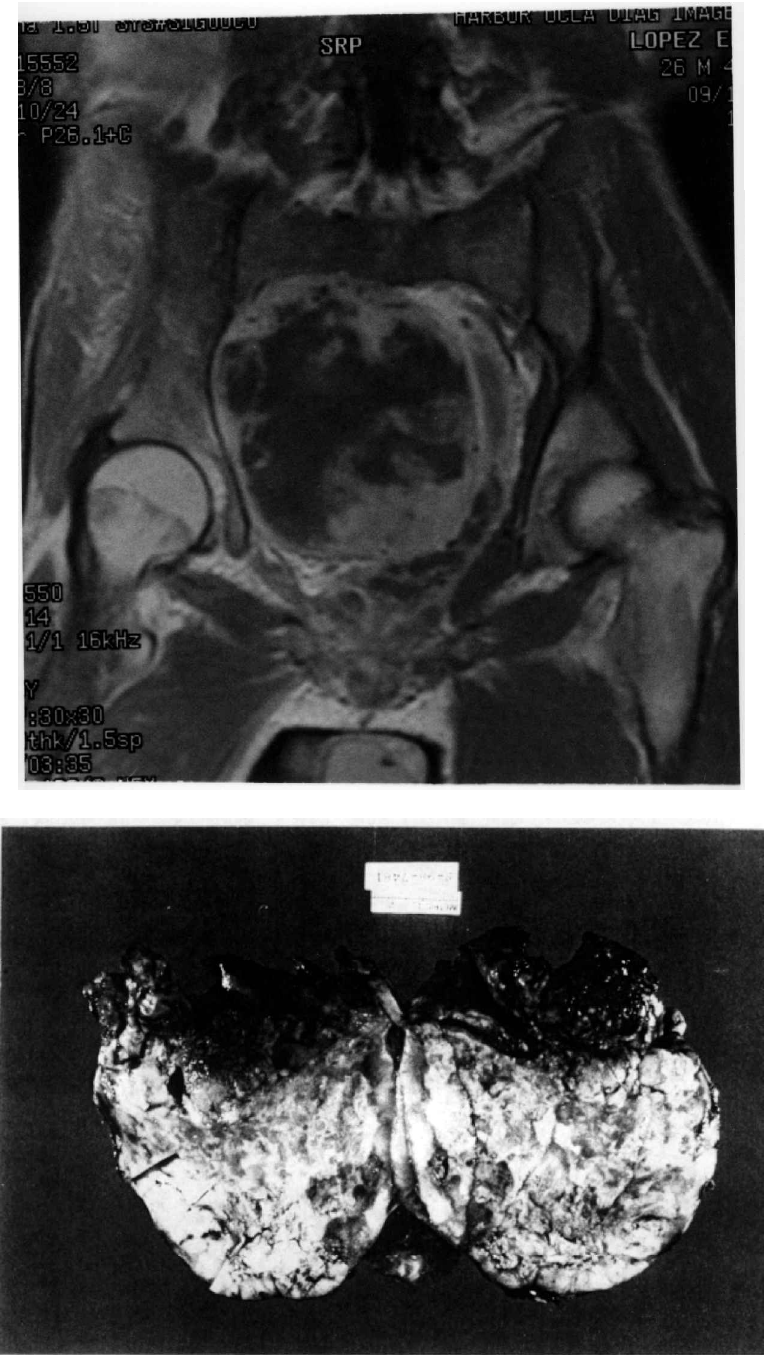
Fig. 1. (A) Magnetic resonance imaging showed a large pelvic mass displacing rectum medially and anteriorly. (B) Bisected tumor mass revealed a variegated tan light yellow to tan brown cut surface with extensive necrosis, focal hemorrhage and gelatinous degenera-